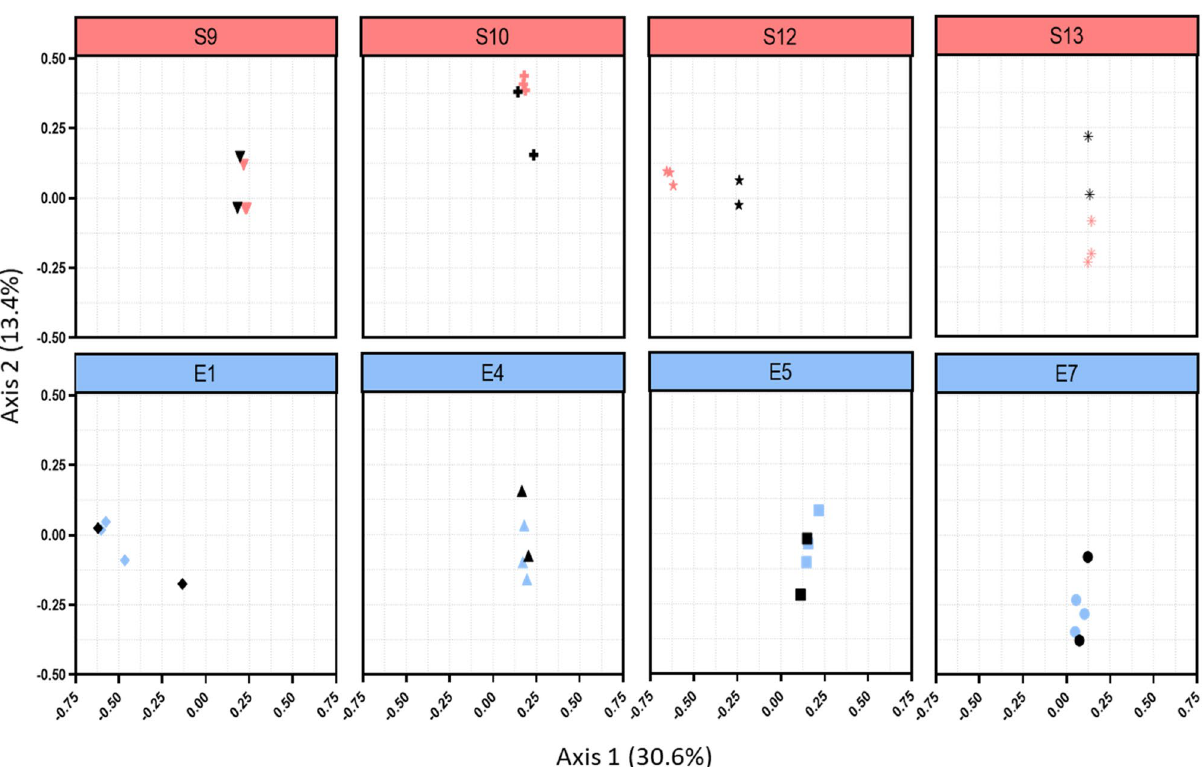
Figure 6. PCoA of weighted Bray–Curtis beta diversity in-mission compared to pre-mission for a subset of subjects. Subjects on the enhanced diet (blue) showed more stability in both richness and evenness between all pre- and in-mission samples compared to subjects on the standard diet (red). Black symbols denote pre-mission